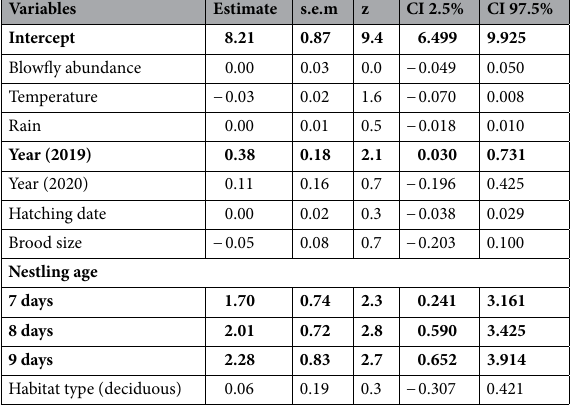
Table 6. Model-averaged variables best explaining the body mass (g) of Wood Warbler nestlings (response variable). Shown are averaged coefficients and confidence intervals (CI) across models with ΔAICc < 2 (Table 5; conditional average). Significant relationships ( P < 0.05) are marked in bold. For the description of covariates see Table